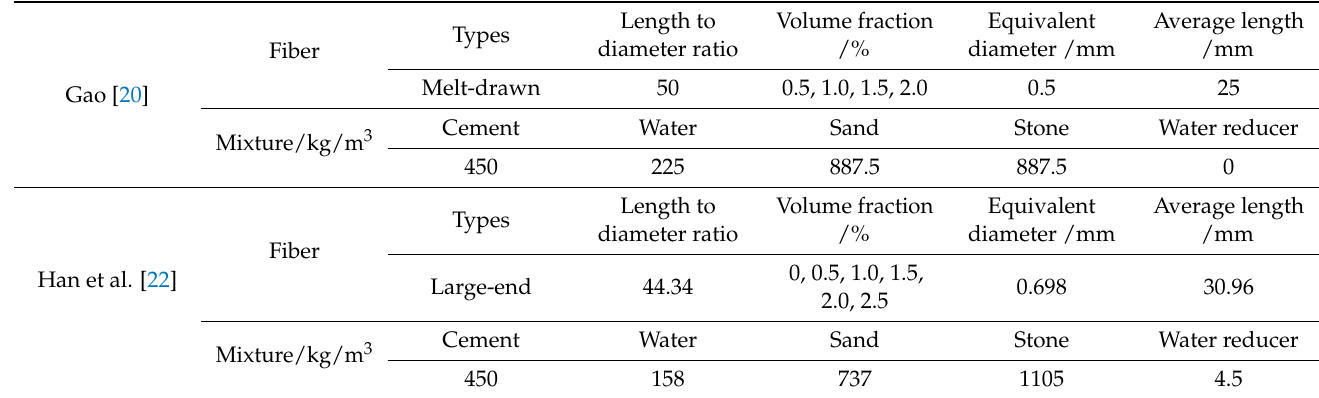
Table 2. Summary of uniaxial tensile test